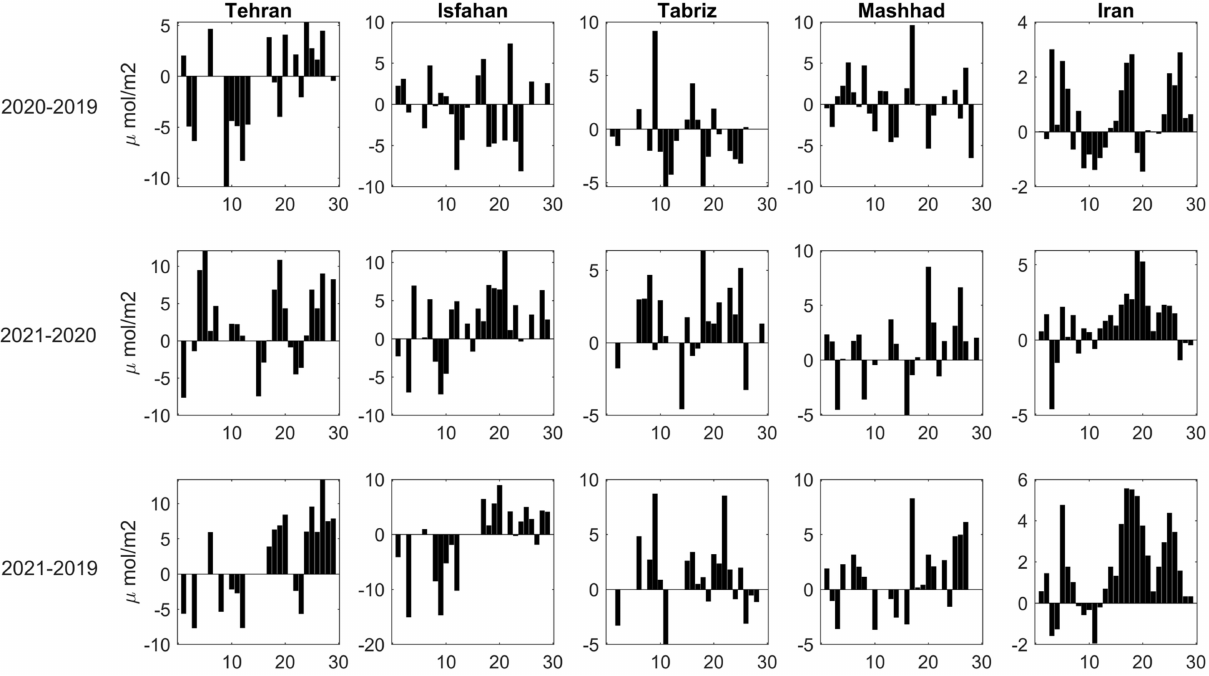
Figure 8. The difference charts of the daily CO amount during March/April 2020–2019 ( first row ), 2021–2020 ( middle row ), and last row